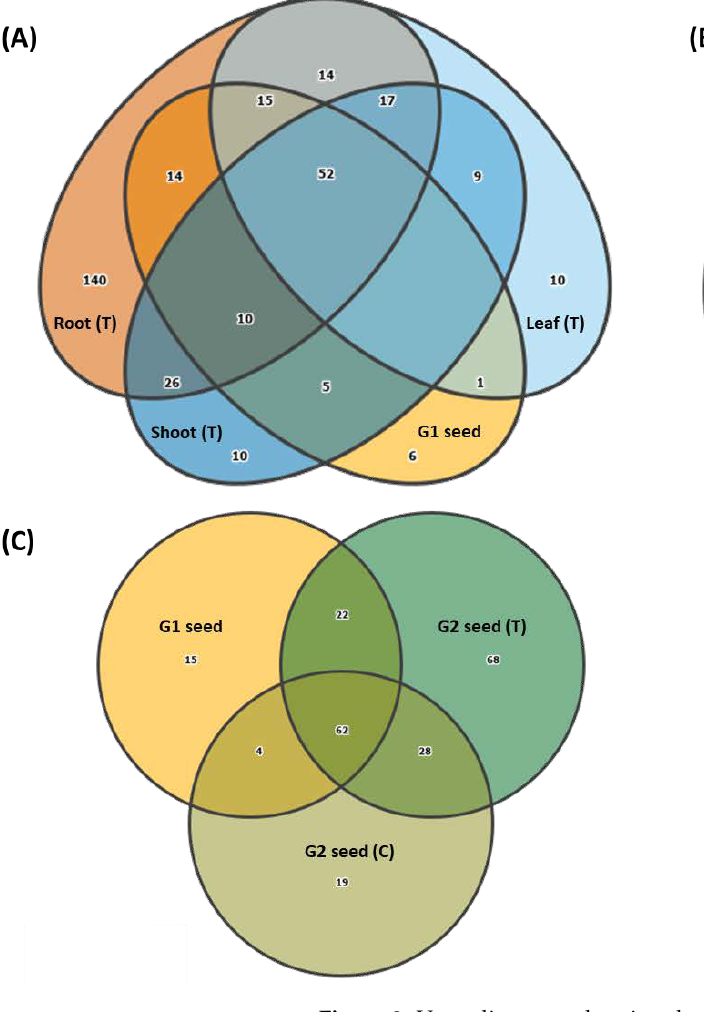
Figure 8. Venn diagrams showing the transmission of G1 bacterial genera across G1 plant organs (root, shoot and leaf) for( A ) Treatment (T) and ( B ) Control and ( C ) G2 seed (T and C)